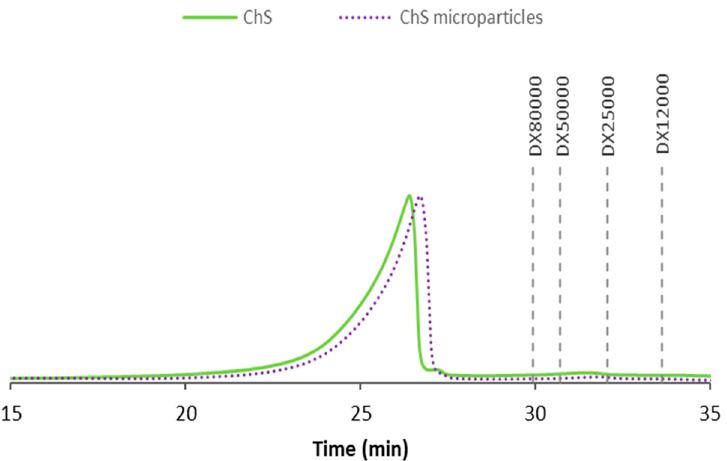
Figure 3. High-performance size-exclusion chromatography (HPSEC) profiles of chondroitin sulphate (ChS) as raw material, represented by the continuous line, and after processing by spray-drying (unloaded microparticles), illustrated by the dotted line.